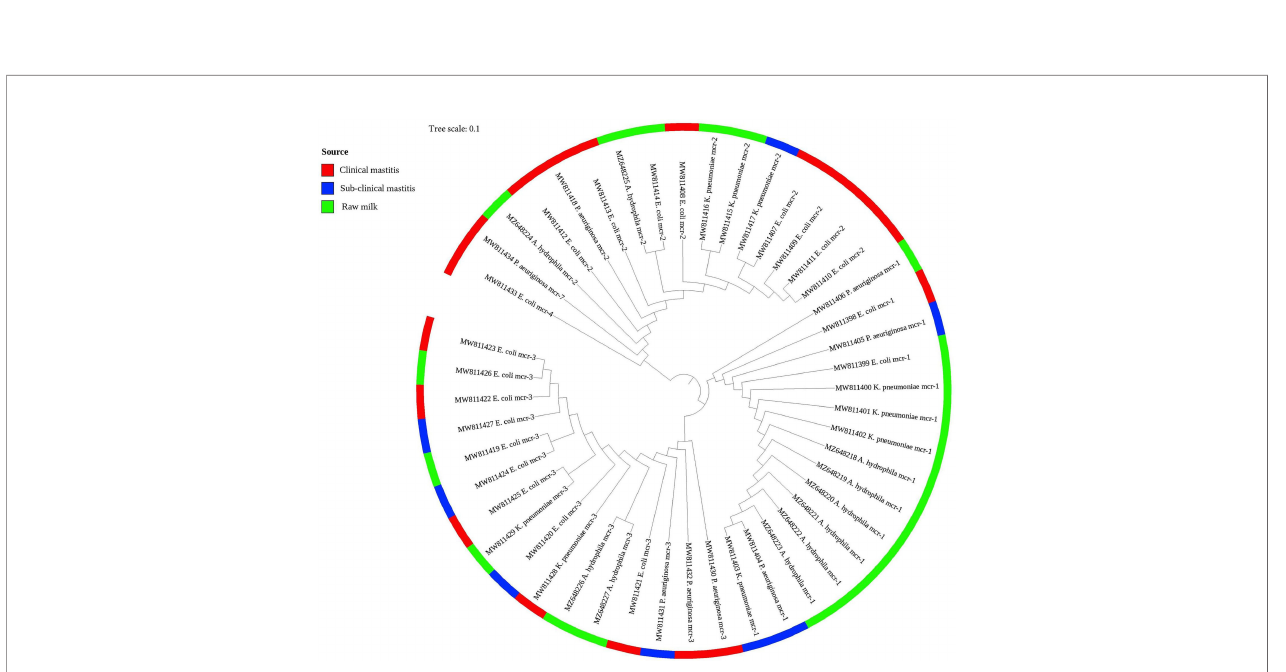
FIGURE 2 | A phylogenetic tree shows the genetic relationship between mcr gene sequences of colistin-resistant Gram-negative bacteria recovered from clinical, subclinical mastitis, and raw milk. The tree was constructed using a neighbor-joining method with a bootstrap value for 1,000 replicates.